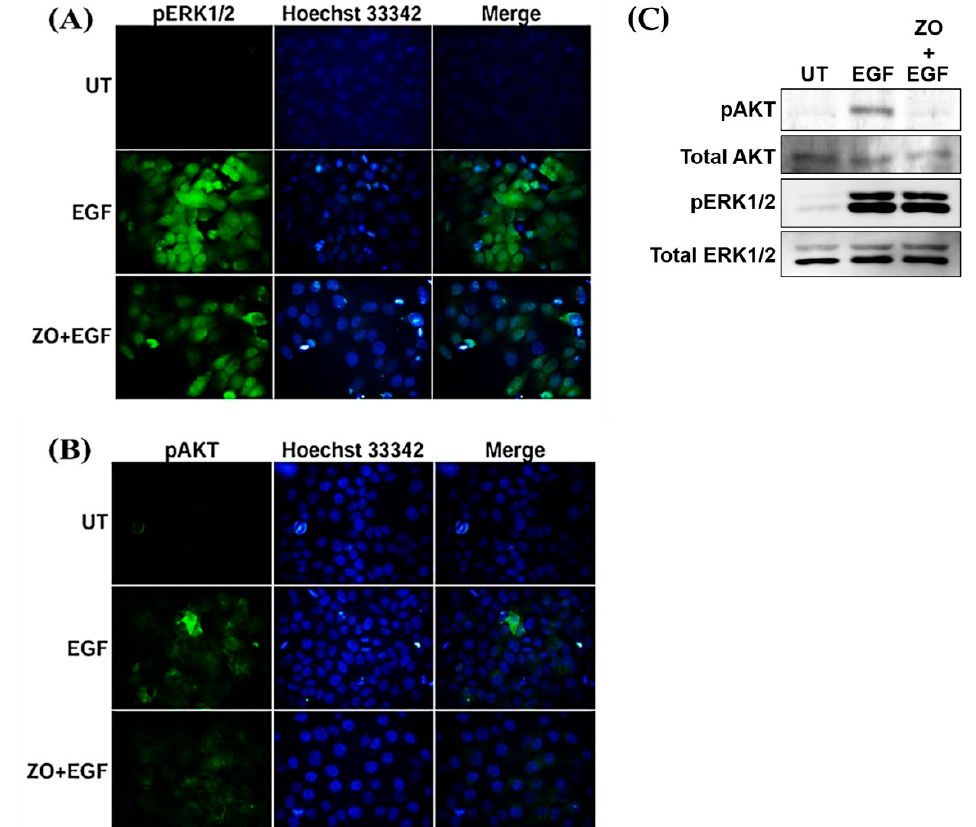
Figure 5. Immunofluorescence study for the effects of ZO essential oil at the dilution of 1:25,000 on ( A ) pERK1/2 and ( B ) pAkt activation. HeLa cells were stained with Hoechst 33342 for nuclear staining (blue). Micrographs were photographed by a fluorescent microscope (100 × magnification). ( C ) Western blot analysis detecting the phosphorylation (activation) status of ERK1/2 and Akt kinases and their total protein expression.